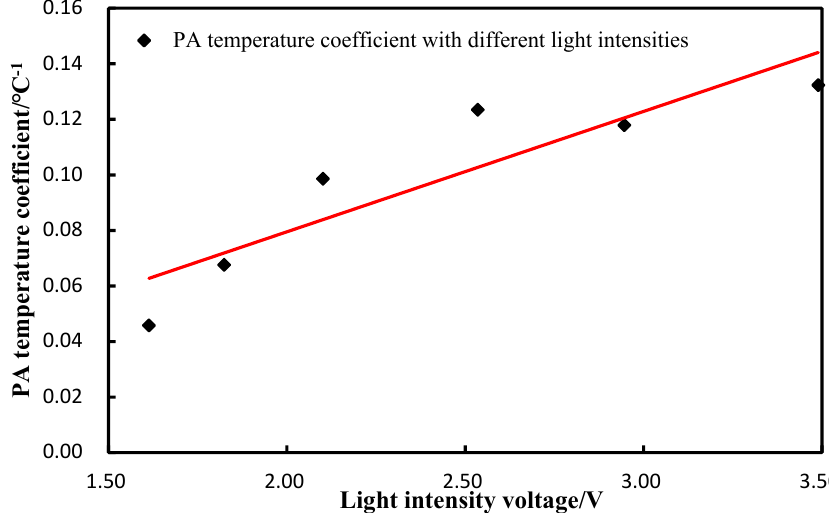
Figure 4. Relation of the temperature coefficient to light intensity.